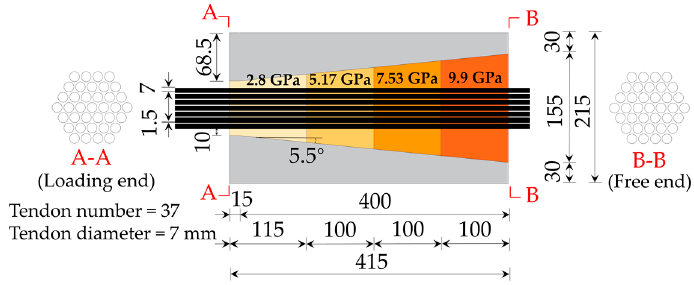
Figure 1. Previous parallel-tendon CAS (dimensions in mm).